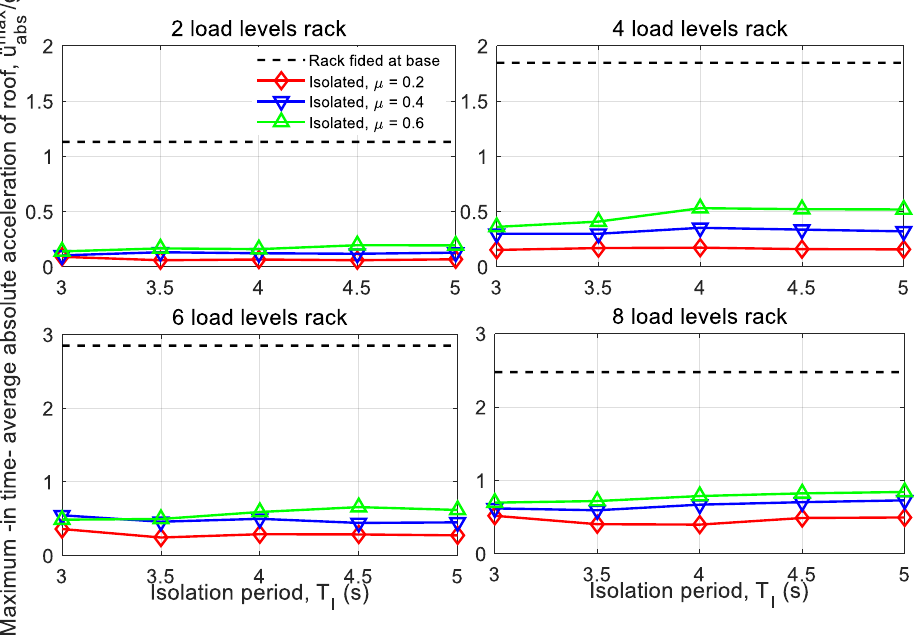
Figure 10. Maximum acceleration in racks with base isolation with different load levels, friction coefficient ( μ ) and isolation period ( 𝑇 𝐼 ). The black dotted line is the response for fixed base racks.